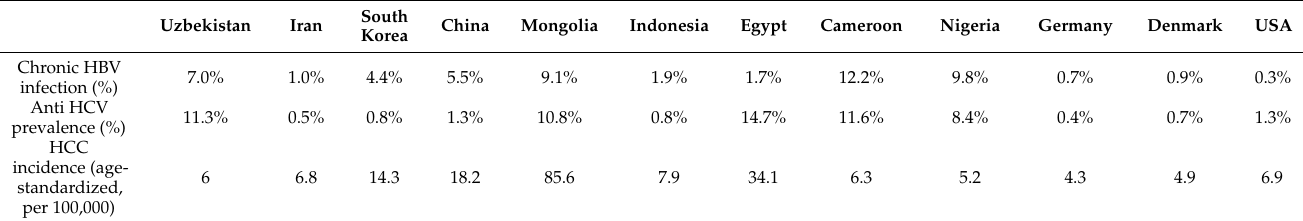
Table 3. Epidemiology of viral hepatitis and hepatocellular